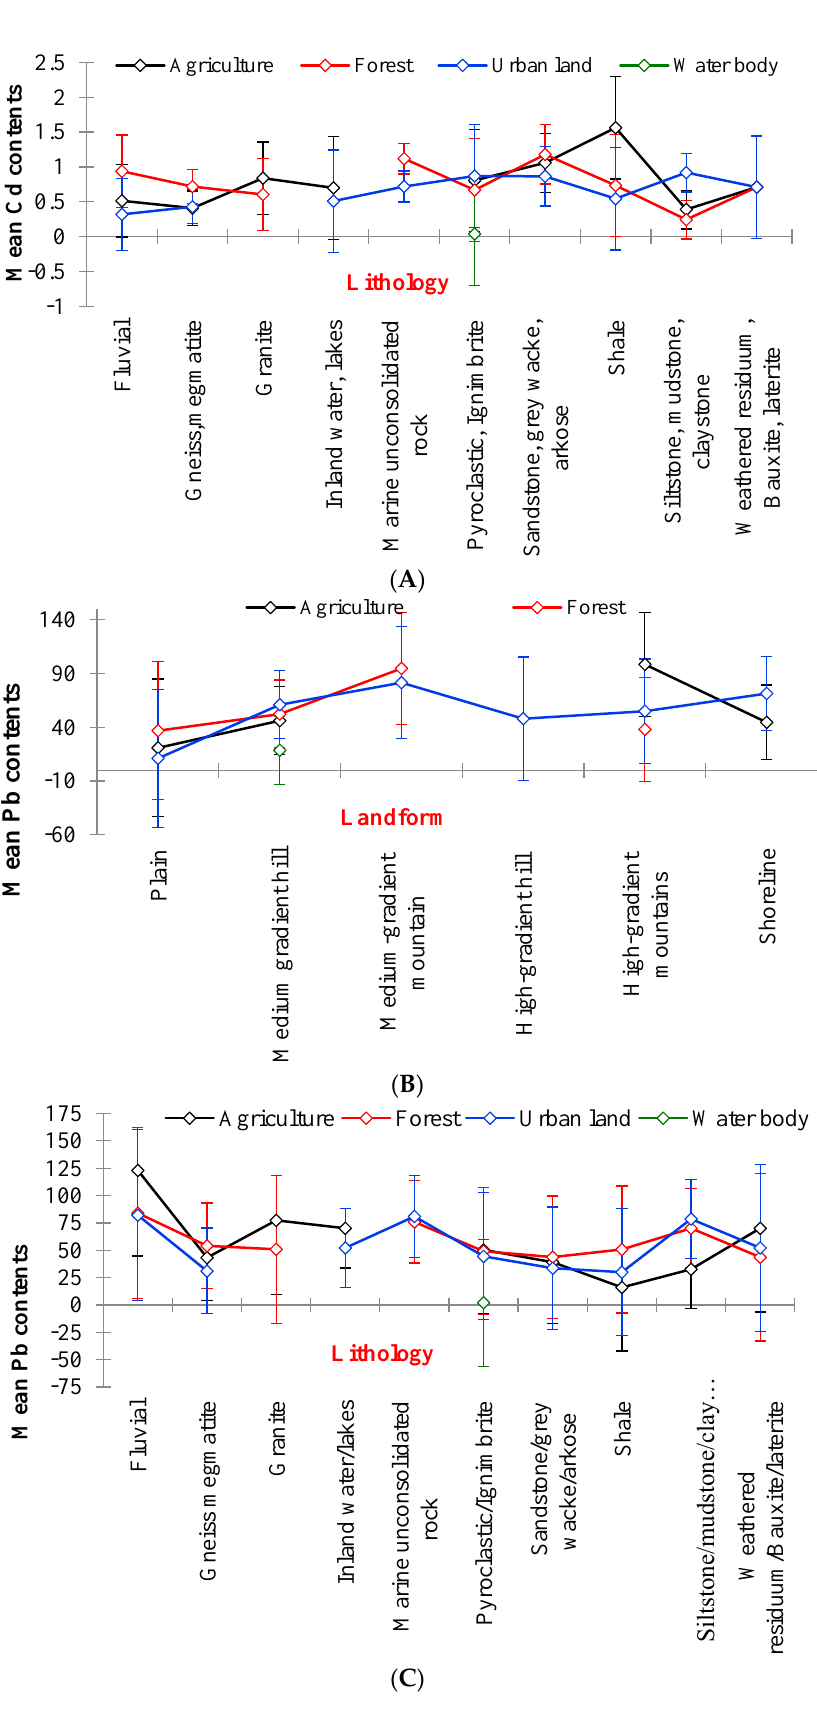
Figure 8. Combined effects of ( A ) land use and lithology on Cd ( B ) land use and landform on Pb, and ( C ) land use and lithology on Pb contents.